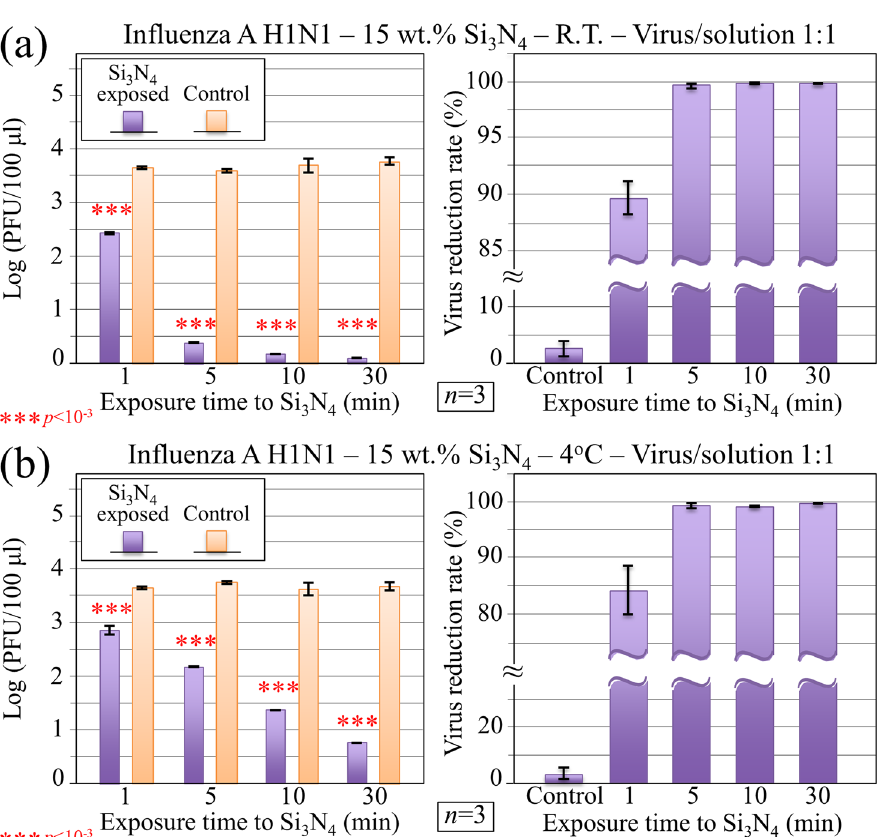
Figure 4. Immunochemistry results collected on MDCK cells infected with Influenza A H1N1 virus at room temperature (R.T.) and at 4 °C in ( a ) and ( b ), respectively. Data are plotted (with statistical validation) in logarithmic scale as PFU counts and virus reduction rate as a function of virus exposure time to 15 wt.% Si 3 N 4 in aqueous solution. Control samples refer to virions embedded for the same time in aqueous environment in absence of the Si 3 N 4